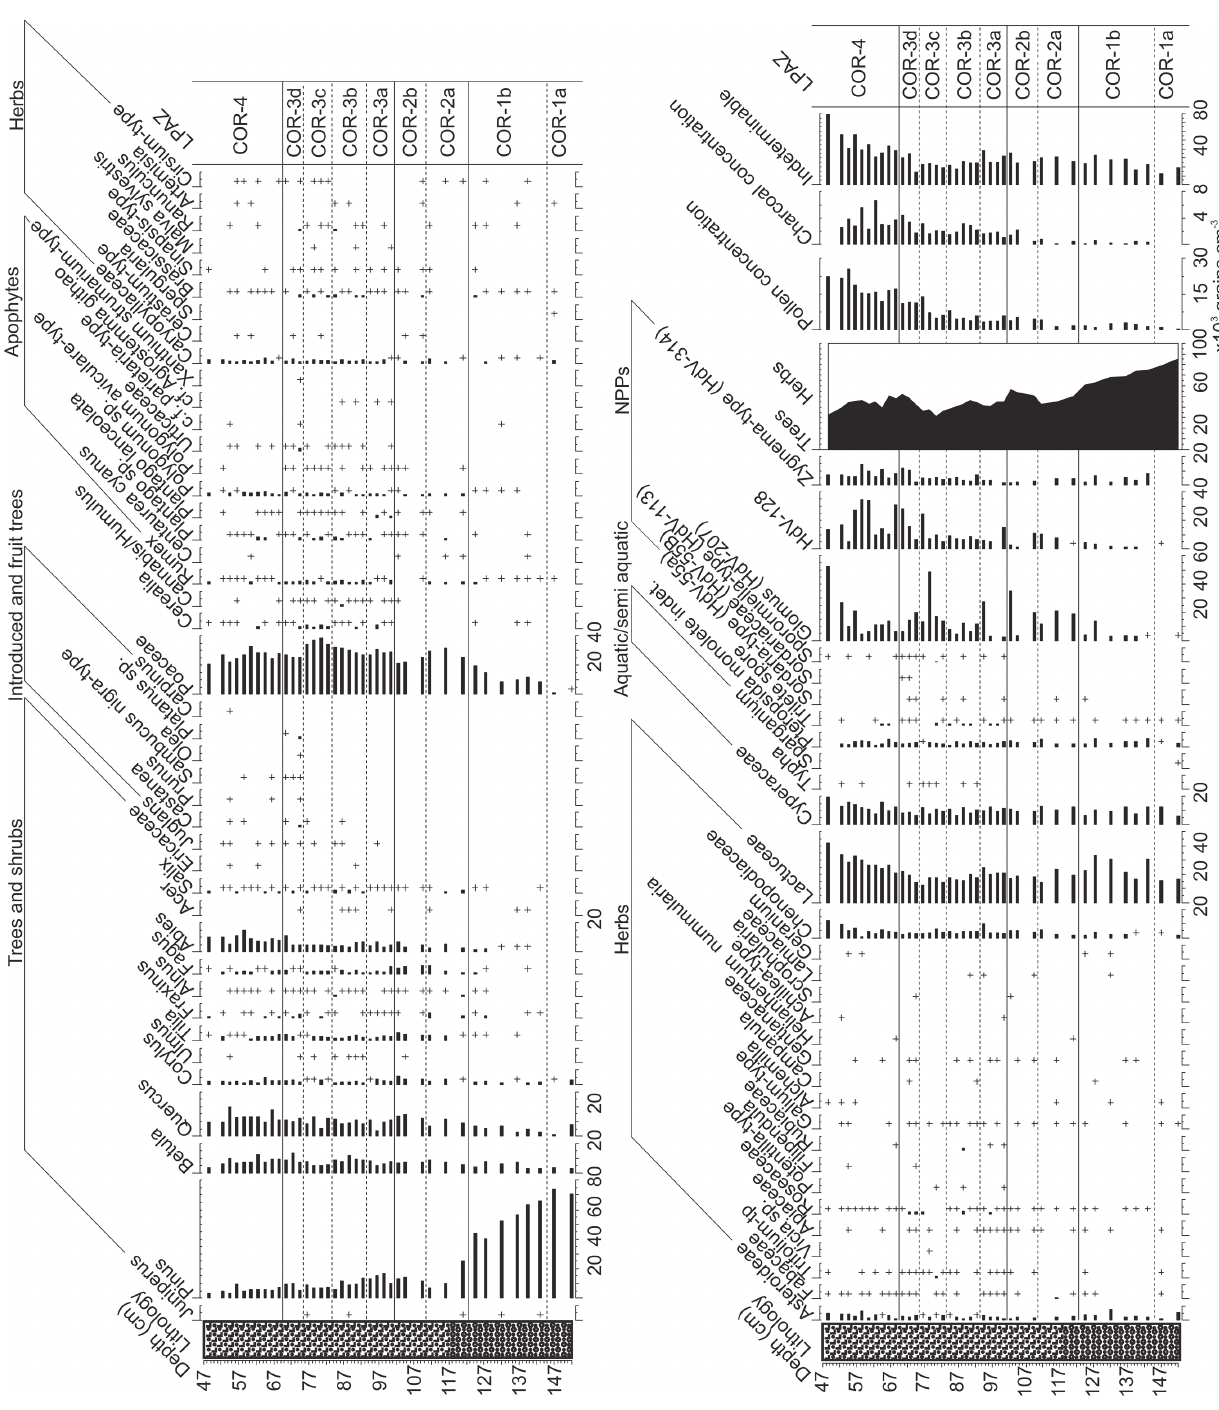
Fig 7. Percentage pollen and spore diagram displaying selected taxa (based on TLP sum – Lactuceae). Also shown is the lithology, microscopic charcoal and total pollen concentration. + indicates < 1% TLP.